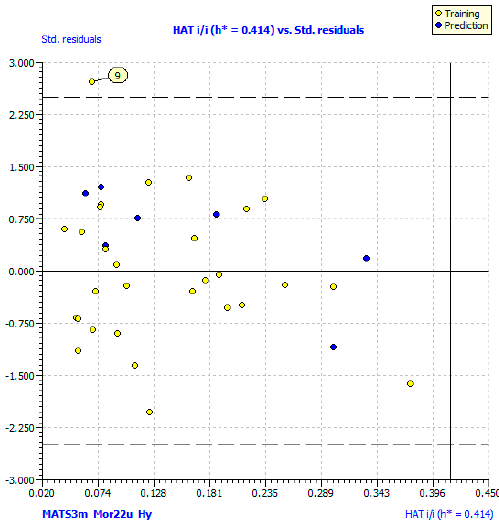
Figure 2. Williams plot of the applicability domain of the the QSAR model for antioxidant activity calculated by model (1).